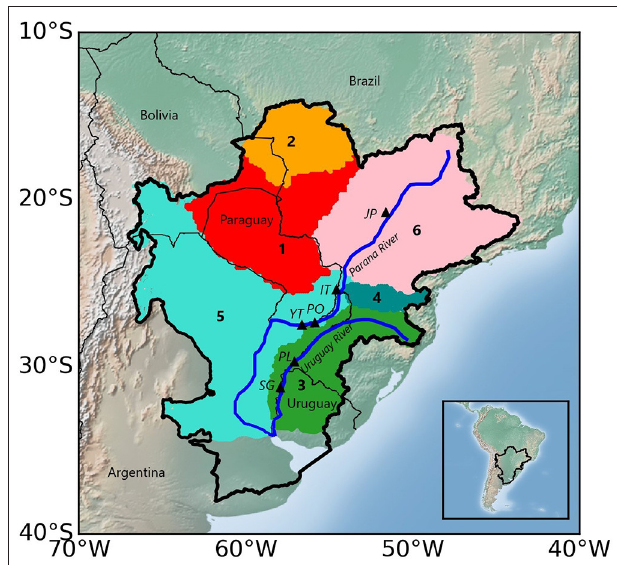
FIGURE 1 | Location of the LPB in South America and the six sub-basins considered in the study: (1) the lower and (2) upper Paraguay River basins, (3) the Uruguay River basin, (4) the Iguazú River basin and (5) the lower and (6) upper Paraná River basins. The black triangles indicate the location of the considered closing points and river dams: Jupiá (JP), Itaipú (IT), Posadas (PO), Yacyretá (YT), Paso de los Libres (PL), and Salto Grande (SG). The inset in the lower right corner of the figure shows the location of LPB within South